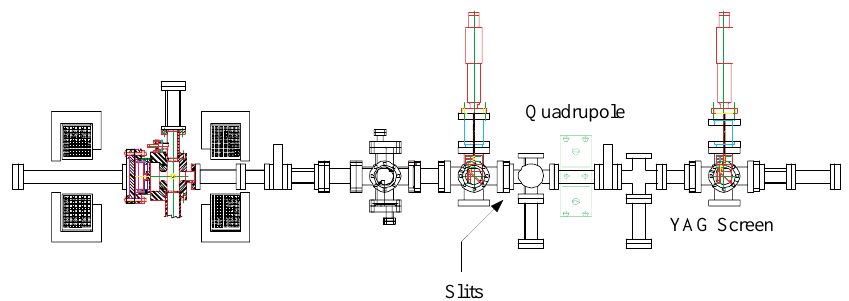
FIG. 3. (Color) Schematic of the LLNL Thomson scattering beam line used in the emittance measurements.